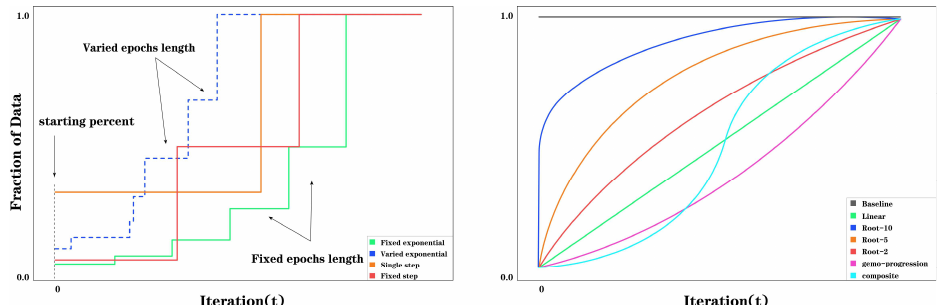
Figure 7. Visualization of static training schedulers. The horizontal axis indicates the number of training iterations, and the vertical axis indicates the proportion corresponding to the data.